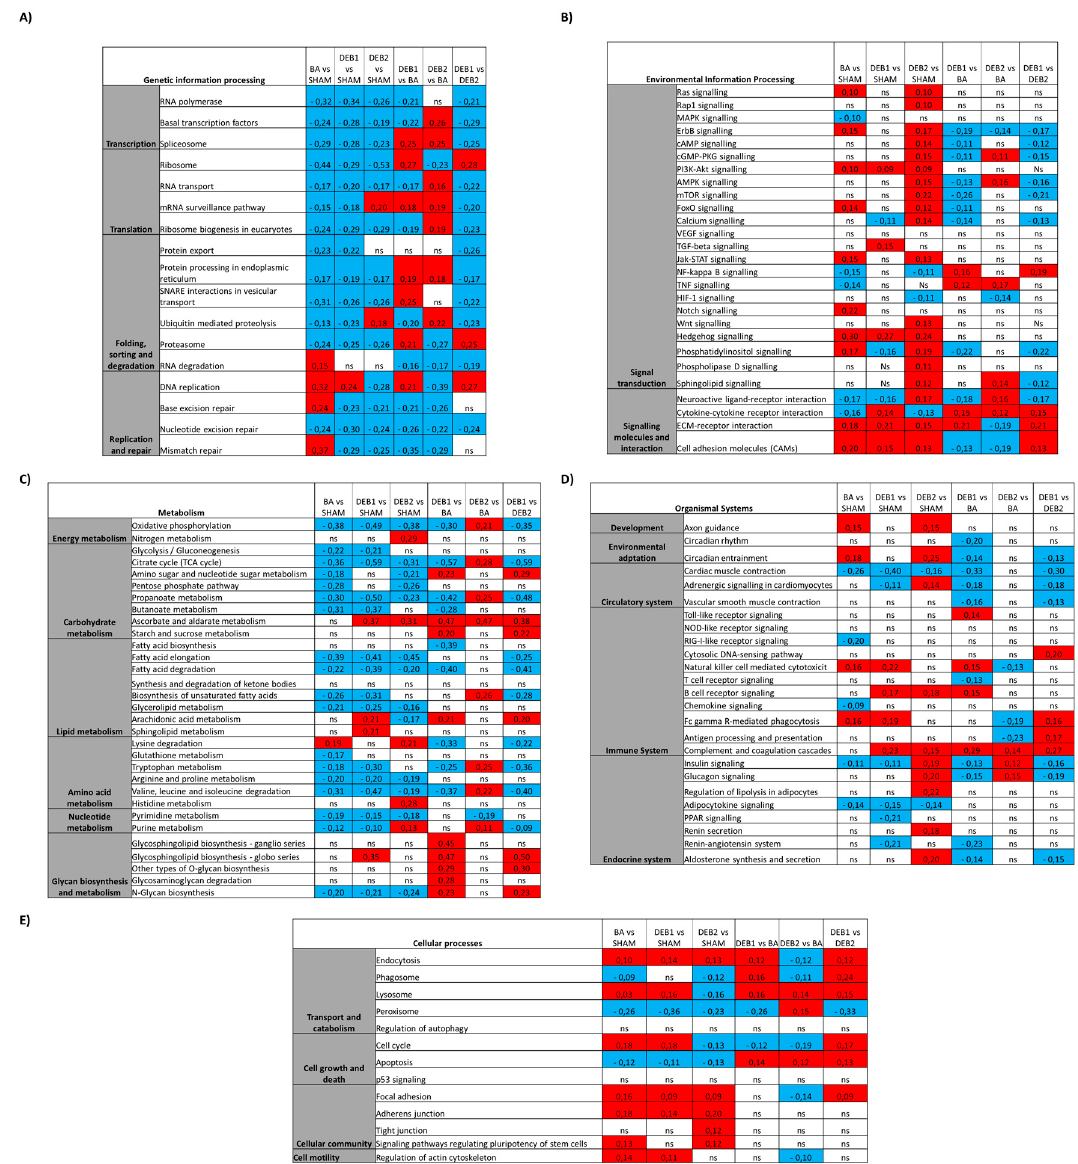
Figure 3. Gene-term Enrichment Pathways analysis. Tables show pathways related to genetic information processing ( A ), environmental information process ( B ), metabolism ( C ), organismal systems ( D ), and cellular processes ( E ) for SHAM vs. BA, DEB1 and DEB2; BA vs. DEB1 and DEB2; and DEB1 vs. DEB2. The MES value, which represents the level of a pathway, is showed for each comparison. A positive MES value (red squares) indicates higher gene enrichment (up-regulation), whereas a negative MES value (blue squares) indicates lower gene enrichment (down-regulation) for each pathway.